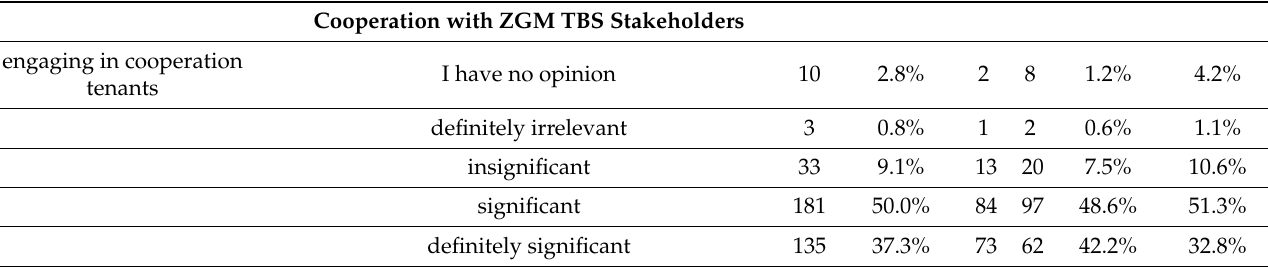
Table 7. The importance of cooperation with ZGM TBS stakeholders.